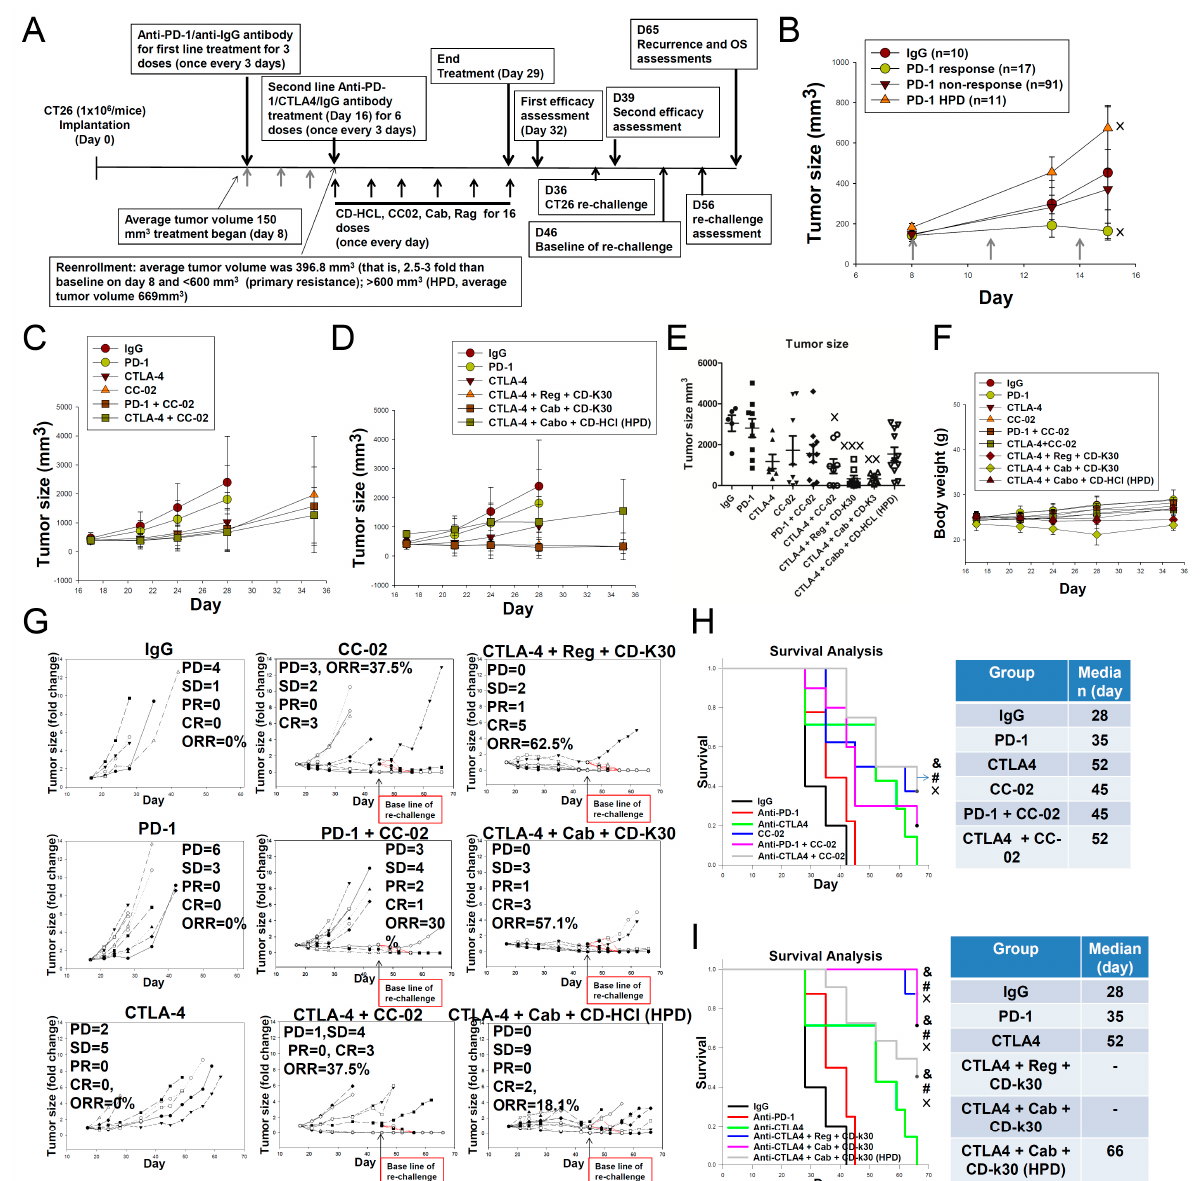
Figure 5. ( A ) shows the consecutive treatment schedule and responsive results of the first-line anti-PD-1 Ab treatment. Male Balb/c mice bearing subcutaneous CT26 tumors (1 × 10 6 cell/mice) were treated with a first-line therapy of anti-PD-1 Ab (mean tumor volume: 150 mm 3 when treatment began). The mice were intraperitoneally (i.p.) administered anti-PD-1 Ab or IgG at 2.5 mg/kg, once every 3 days for 3 doses. When the mice responded to anti-PD-1 Ab with tumor shrinking, they were given three more doses. ( B ) Tumor size (mm 3 ) from mice responsive to first-line anti-PD-1 Ab treatment, in comparison with control group treated with anti-IgG antibody 3 times. *, p < 0.05. Figures 5C–E show the results of a second-line treatment in the mice having anti-PD-1 antibody primary resistance. In the first-line anti-PD-1 antibody therapy, if the tumor showed 2.5- to 3-times consecutive increases in tumor volume and with volumes of <600 mm 3 , the mice were defined as having primary resistance. These mice were subsequently reenrolled and divided into nine groups in a second-line treatment for efficacy study. In the second-line treatment, anti-IgG antibody was as a Ab control, anti-PD-1, and anti-CTLA-4 antibodies were administered intraperitoneally (i.p.) at 2.5 mg/kg, once every 3 days for 6 doses. The combinations in the second-line treatment were: Chidamide-HCL salt (50 mg/kg) + Celecoxib (50 mg/kg) (CC- 02), anti-PD-1(2.5 mg/kg) +CC-02, anti-CTLA-4 antibody (2.5 mg/kg) + CC-02 as shown in ( C )